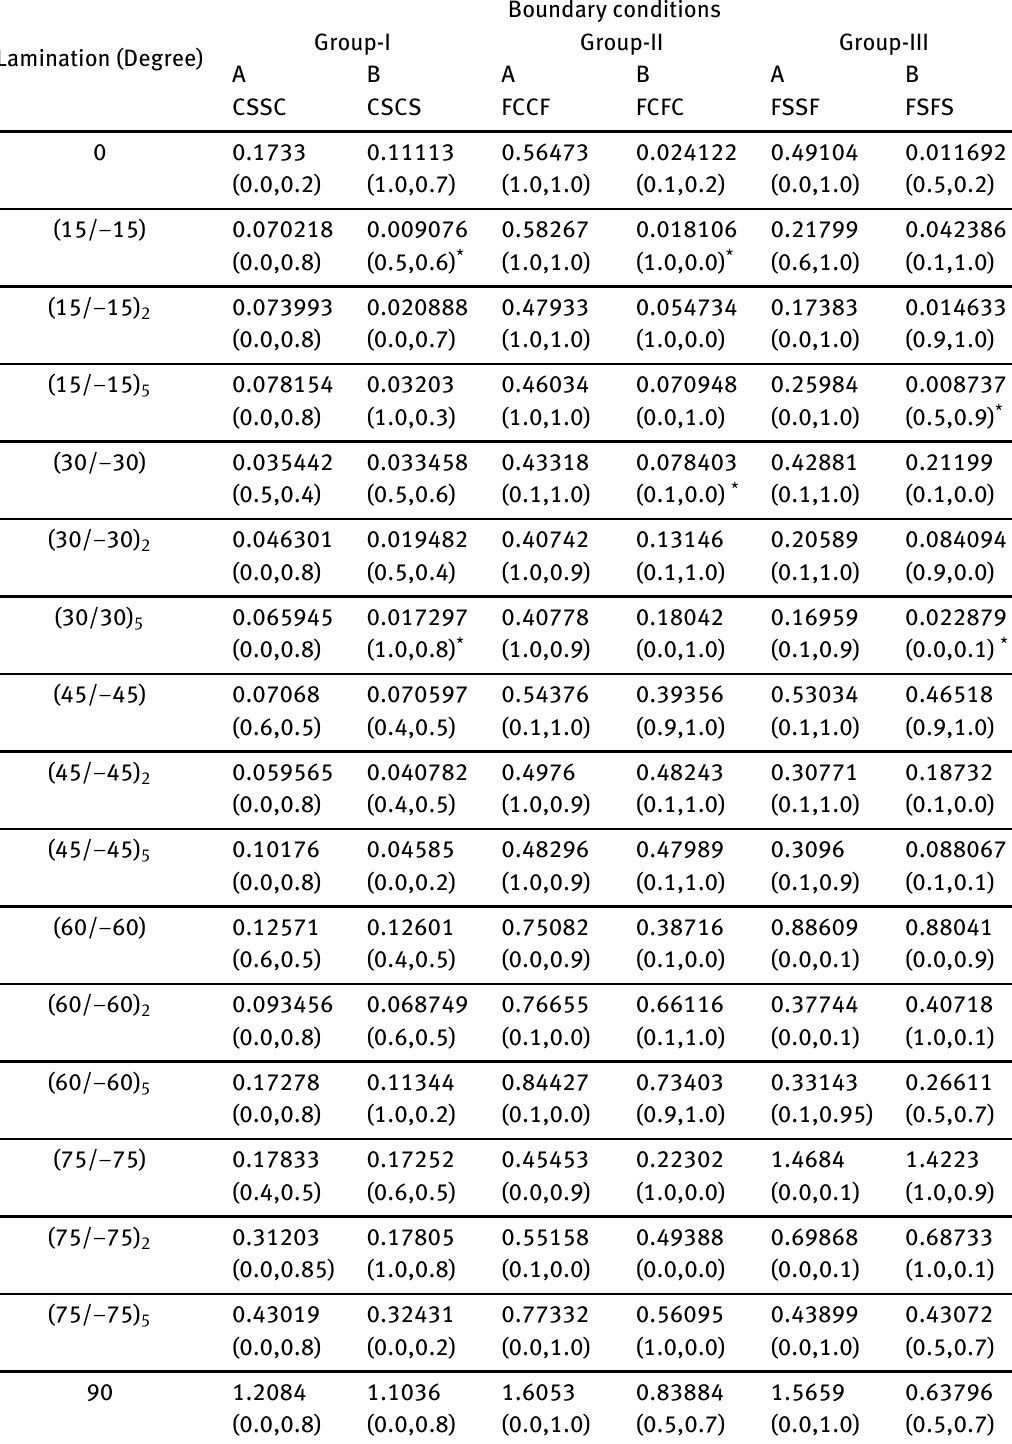
Table 10: Values of maximum non-dimensional hogging moments (+ M x ) x 10 2 for different antisymmetric angle ply lamination and boundary conditions of stiffened composite hypar shell with